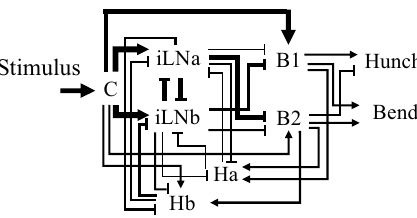
Figure 1. Schematic of the reconstructed Basin circuit. The edge width increases with the number of synapses. The sharp arrowheads indicate excitatory connections, while the square arrowheads indicate inhibitory connections. C: mechano-sensory chordotonal neurons, B1: Basin-1 neuron, B2: Basin-2 neuron, iLNa: inhibitory local interneurons-a, iLNb: inhibitory local interneurons-b, Ha: Handle neuron-a, Ha: Handle neuron-b. Reproduced from Jovanic et al . 32 Fig. 2e with permission from